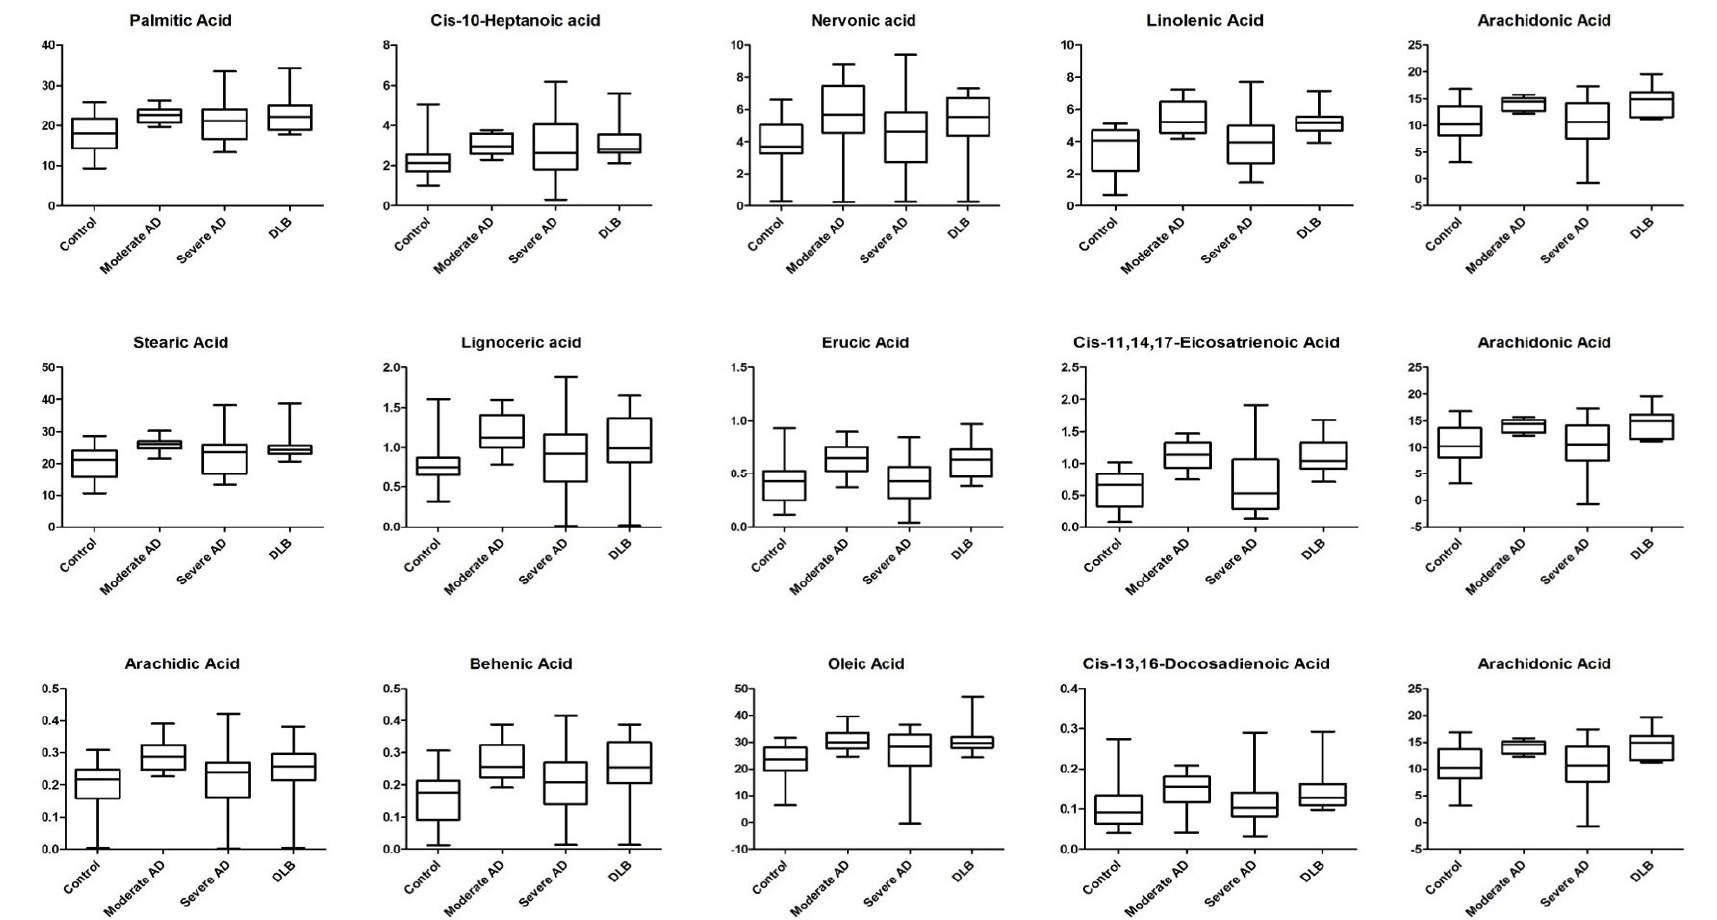
Figure 2. Brain fatty acids (g/kg) significantly altered across moderate Alzheimer’s disease (AD), severe AD, and dementia with Lewy bodies (DLB) groups. A total of 13 brain fatty acid (FA) species were found to be significant across the 4 groups. FA species concentrations are displayed as box-and-whisker plots with maximum and minimum values.